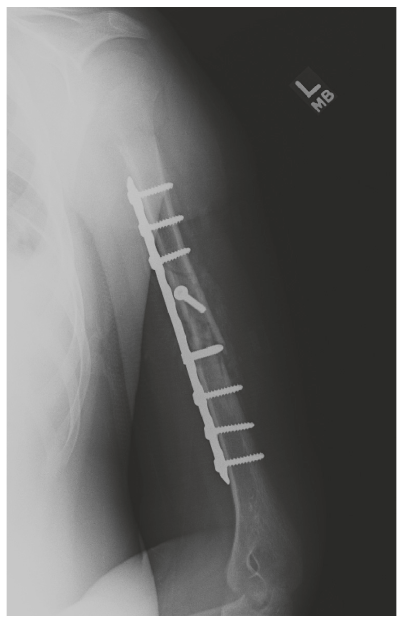
Figure 3: Anteroposterior radiograph following open reduction internal fixation with intact hardware and the fracture in anatomic